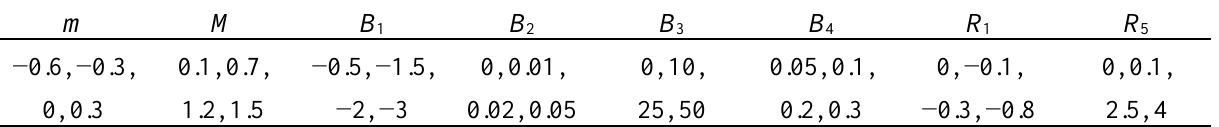
Table 1. Designated values of the dimensionless numbers and